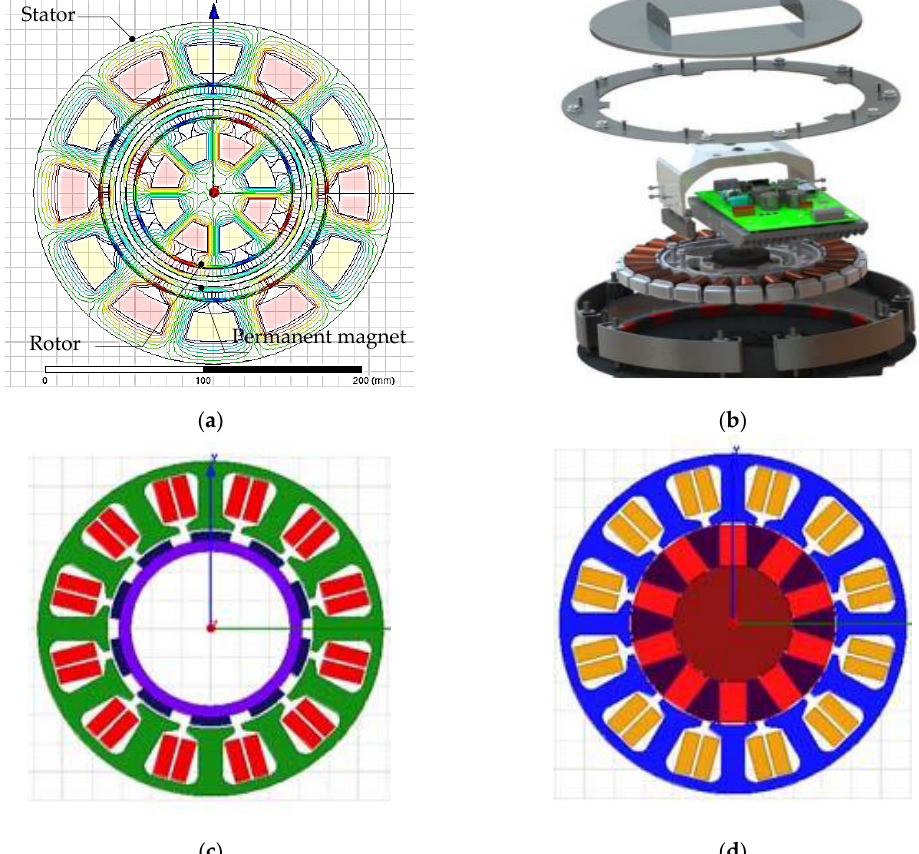
Figure 6. Monstrous fan with permanent magnet motor technology ( a ) Double stator ( b ) Universal Permanent Magnet Synchronous Motor (PMSM) motor [26] ( c ) Surface mount ( d ) Spoke type interior permanent magnet (IPM).